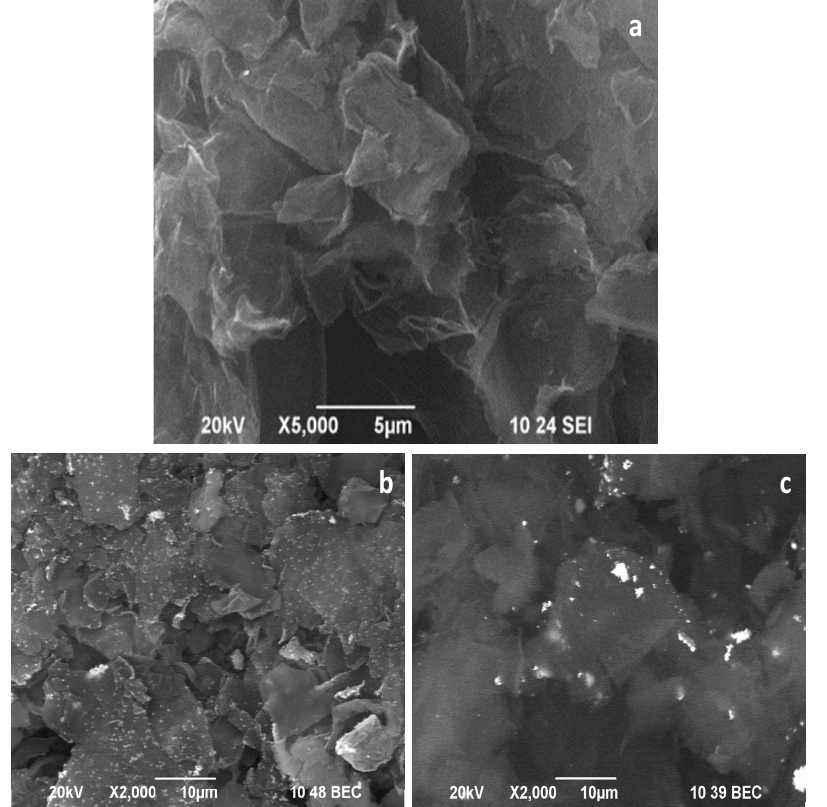
Figure 2. SEM images of: ( a ) RGO in SEI mode, ( b ) Cu–RGO and ( c ) Ag–RGO in BEC mode.